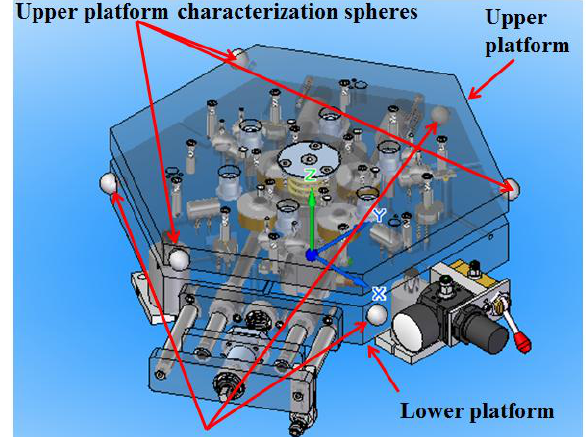
Figure 2. Upper and lower platform characterization